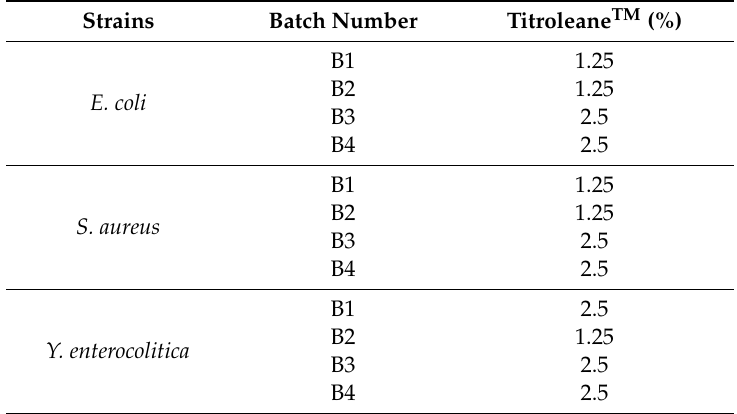
Table 2. Minimal inhibitory concentrations (MICs) of Titroleane ™ from four di ff erent industrial batches. Strains Batch Number